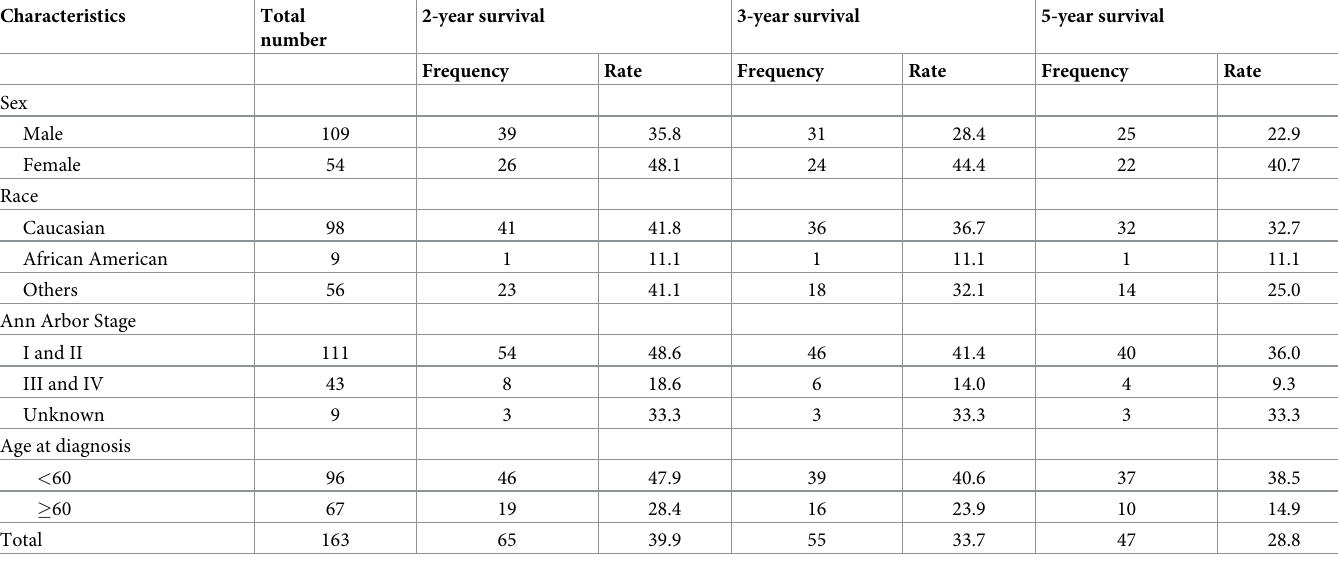
Table 2. Survival of 2-, 3- and 5-year follow-up in patients with extra nodal natural killer/T-cell lymphoma, nasal type in 1987–2014.